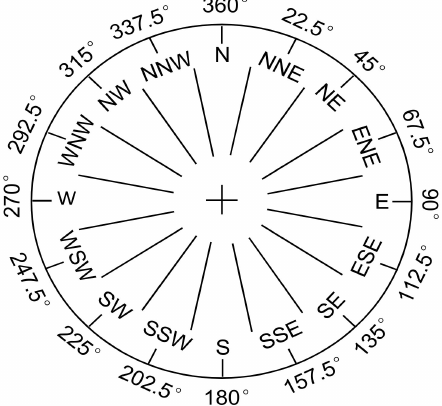
Figure 4. Direction and angle of seeding agent transmission path. Note: Take the example of querying the south wind, which indicates that the end point of the wind direction arrow is in the middle “+”, then the starting point of the arrow is at 180 ◦ marked on the circle, the angle of the south wind is 180 ◦